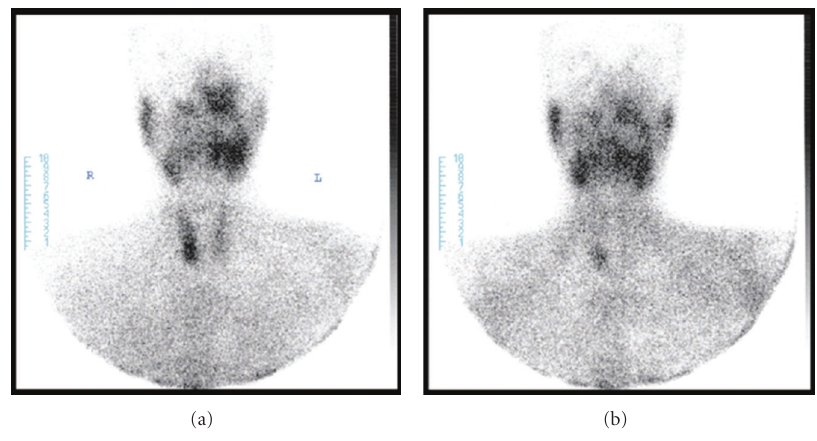
Figure 2: Sestamibi scintigraphy: parathyroid